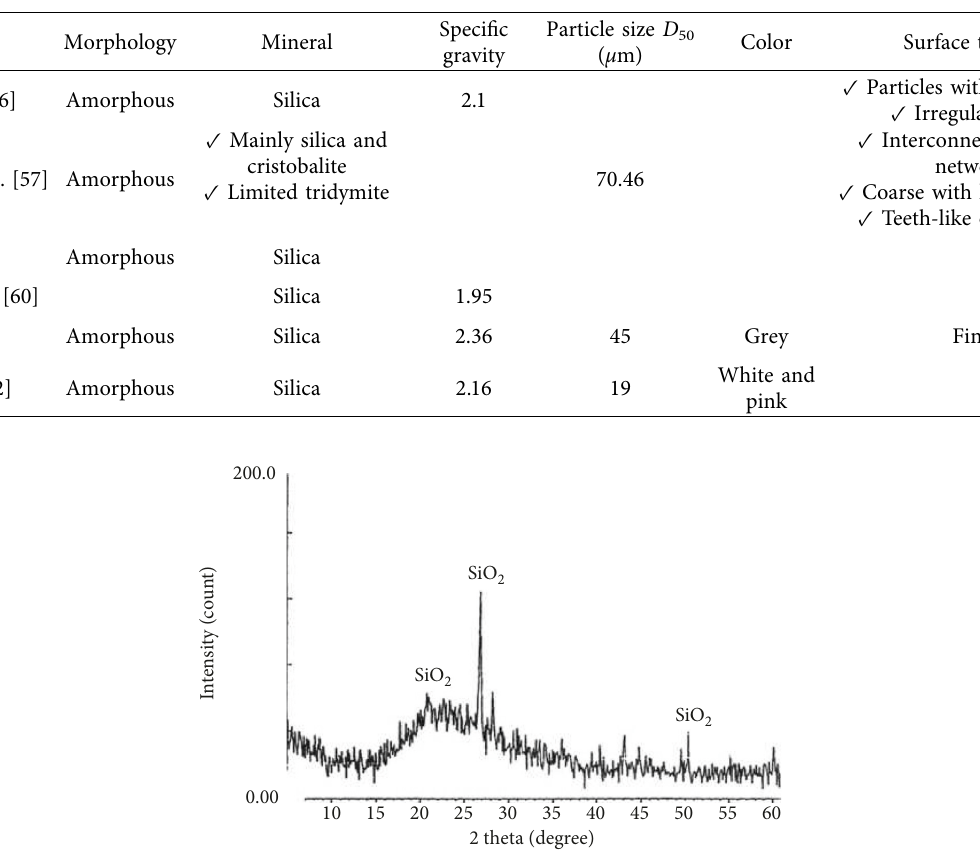
Table 9: Morphological, mineralogical, and physical characteristics of RHA.